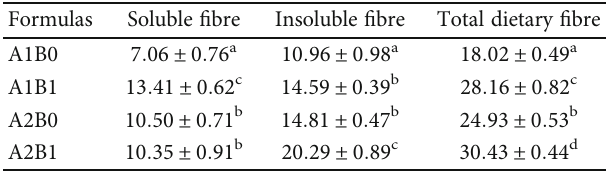
F: formulas. Values are mean ± SD from three replications; the di ff erent superscripts in one column denote signi fi cant di ff erences ( p < 0 : 05 ). Table 5: Dietary fi bre compositions of cream soup formulas. Formulas